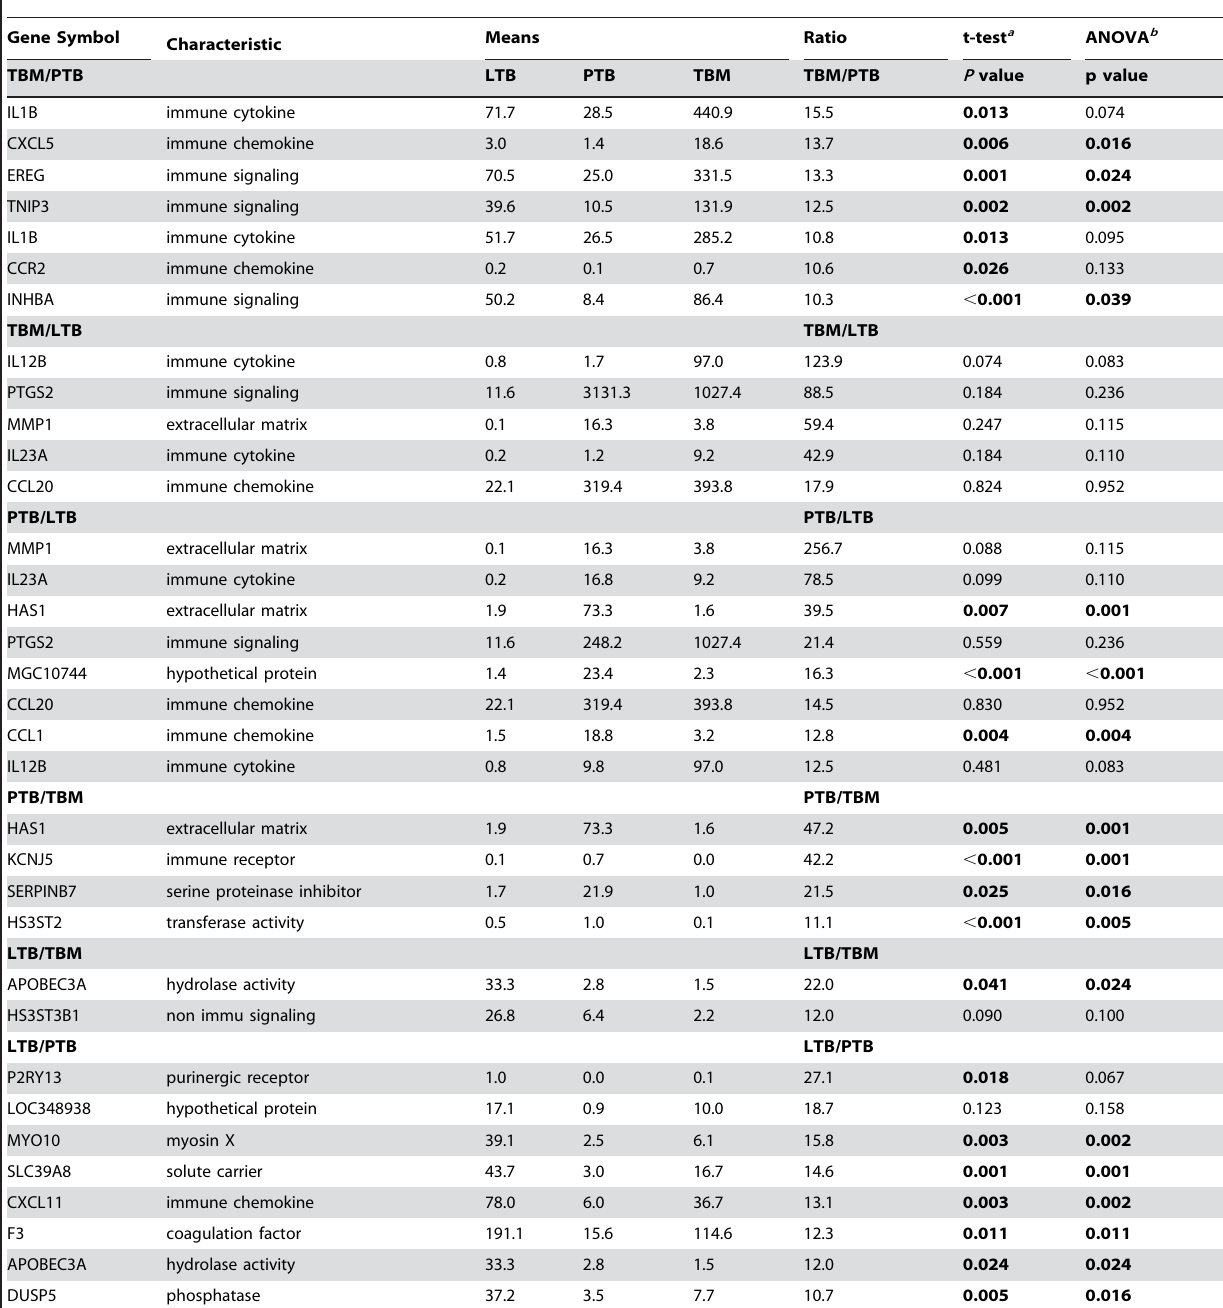
Table 2. Thirty-three genes with altered expression ratios among different clinical forms of TB.